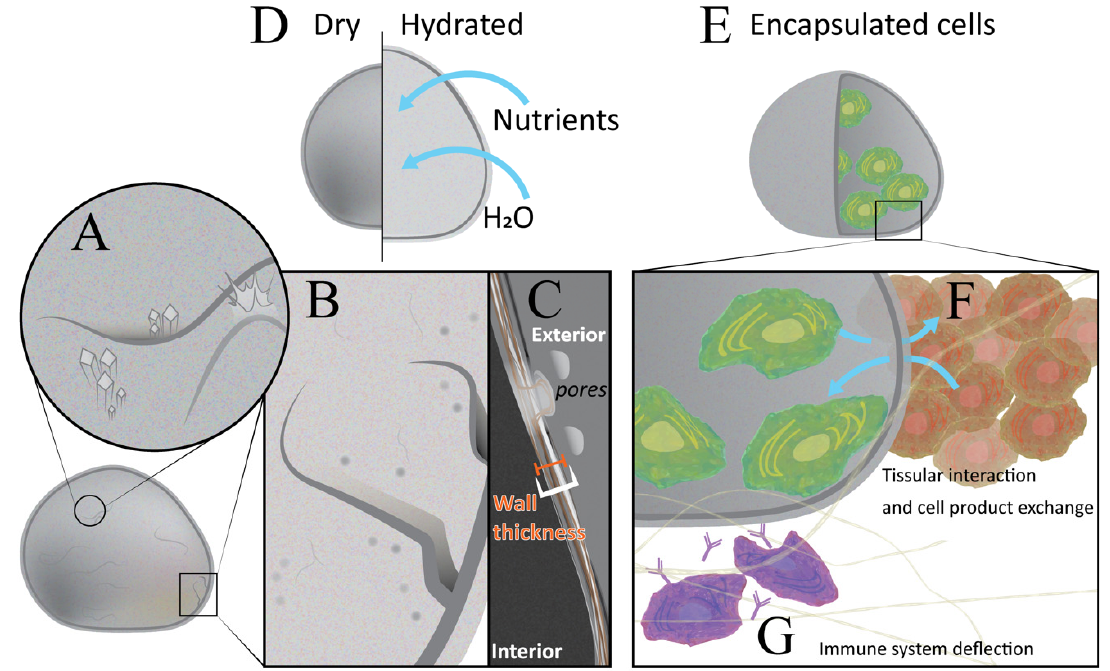
Figure 1. Example of a microcapsule and properties for analysis. ( A ) Microscopic view of the surface of a microcapsule. ( B ) Microcapsule pores and cracks which may be viewed via analysis described in the review. ( C ) Further zoomed view of the microcapsule wall and pores. ( D ) Comparison of a dry and hydrated microcapsule following nutrient and water addition. ( E ) Internal view of a microcapsule showing the encapsulated cells within. ( F ) Magnification of the encapsulated cells showing their interaction and cell product exchange, which may be assessed via methodology outlined within this review. ( G ) Schematic of immune system deflection which is imperative to a successful bioartificial organ and for microcapsules containing cells. Such immunogenic considerations are highlighted in this review. All elements indicated in this schematic can be examined preliminarily via methodology outlined within this review prior to in vivo studies.